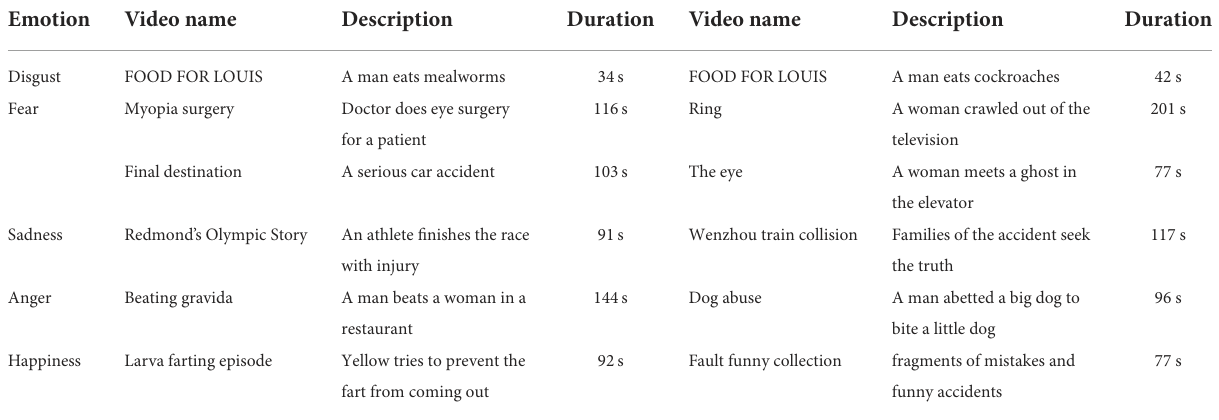
TABLE 2 Details of the emotion elicitation material in our dataset.